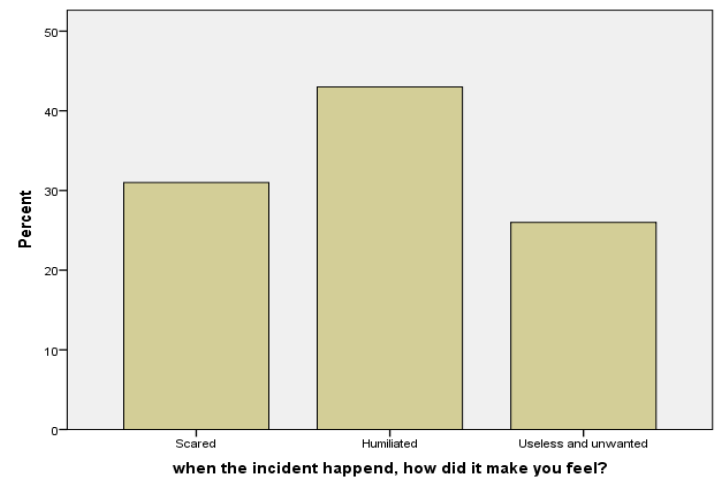
Figure 5: The Reaction of The Respondents after The Incident of Abuse/Crime Happened